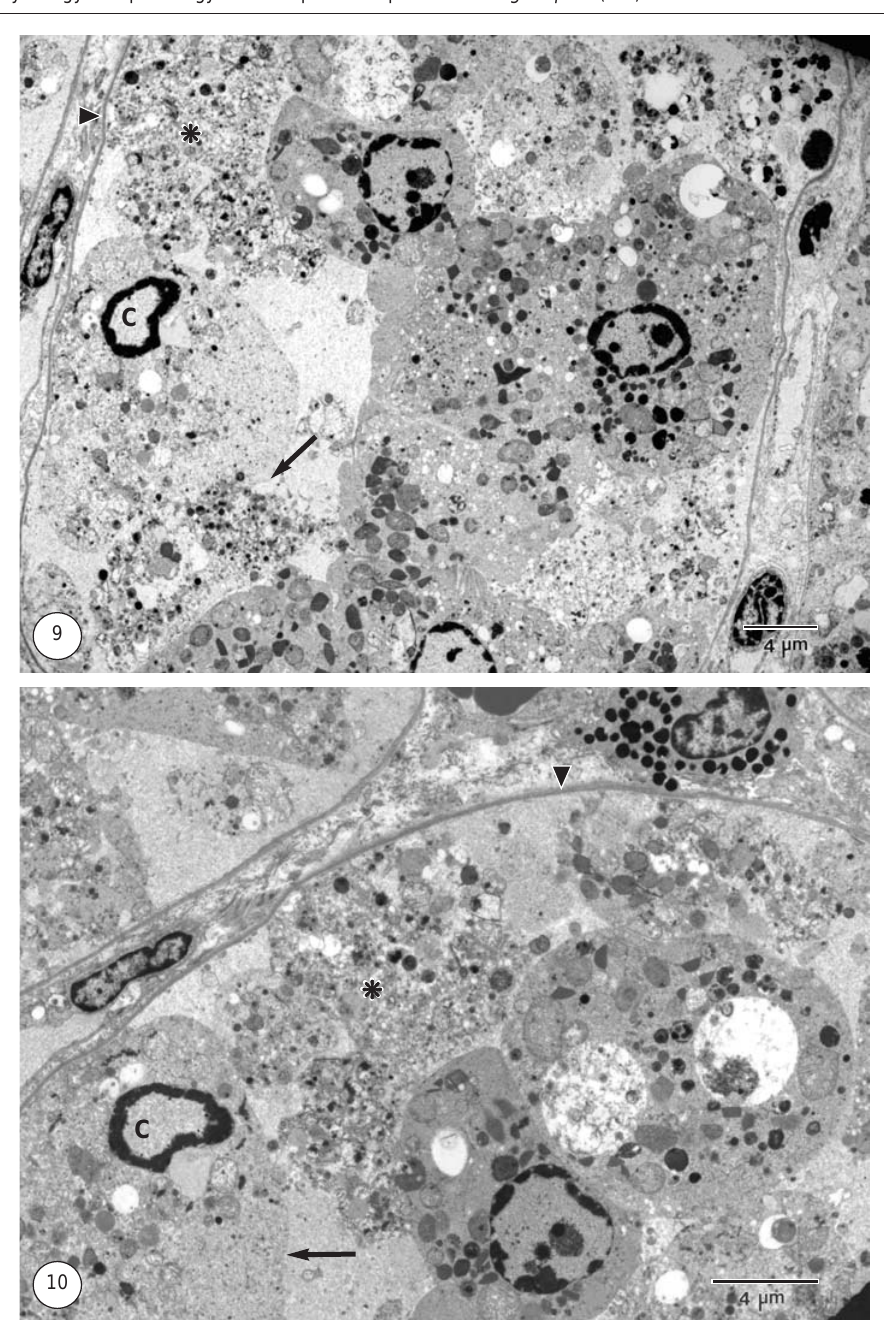
FIG. 9 and 10 Proximal convoluted tubule epithelium. Note the loss of cell membranes ( (cid:133) ) with chromatin margination ( C ). Cytoplasmic organelles are disorganized and dispersed as a loose mass within the tubular lumen( (cid:78) ). The basal membrane is intact (